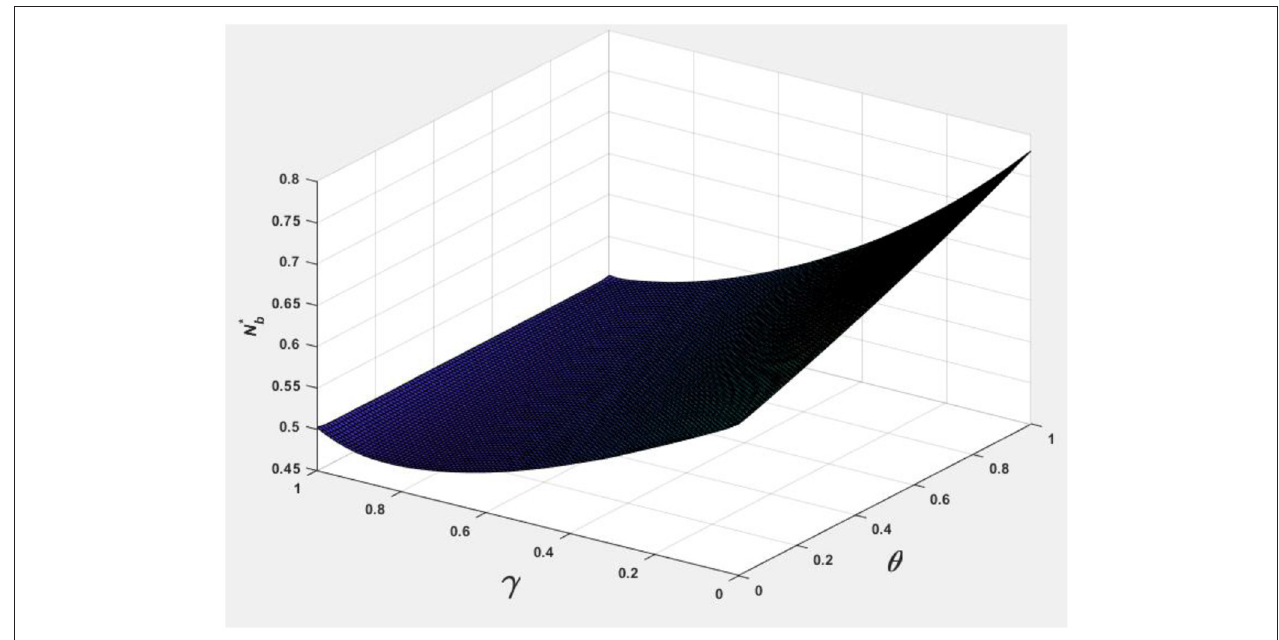
FIGURE 1 | Effect of θ , γ on N * b